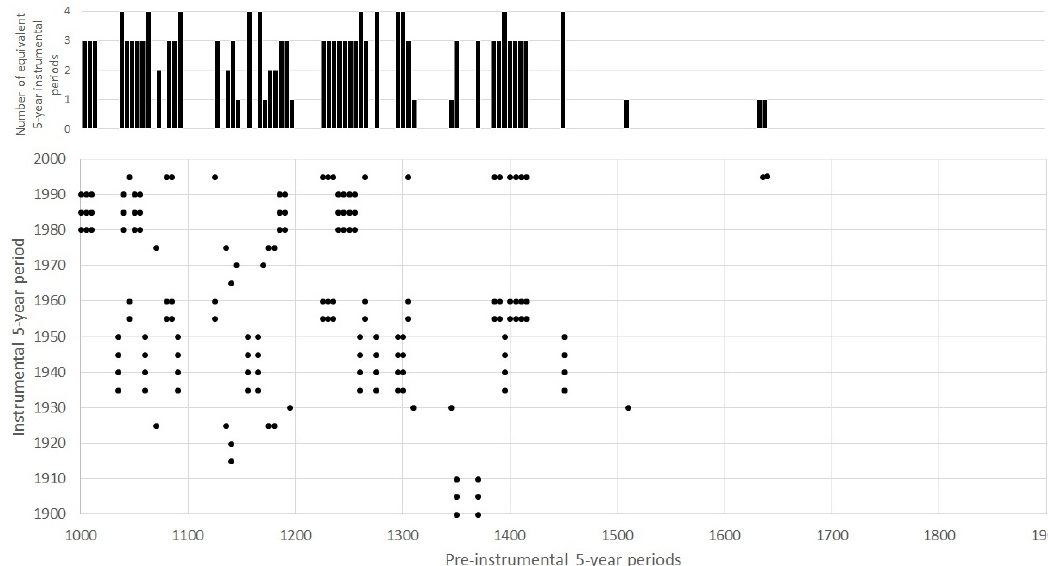
Figure 5. Instrumental equivalents to pre-instrumental 5-year